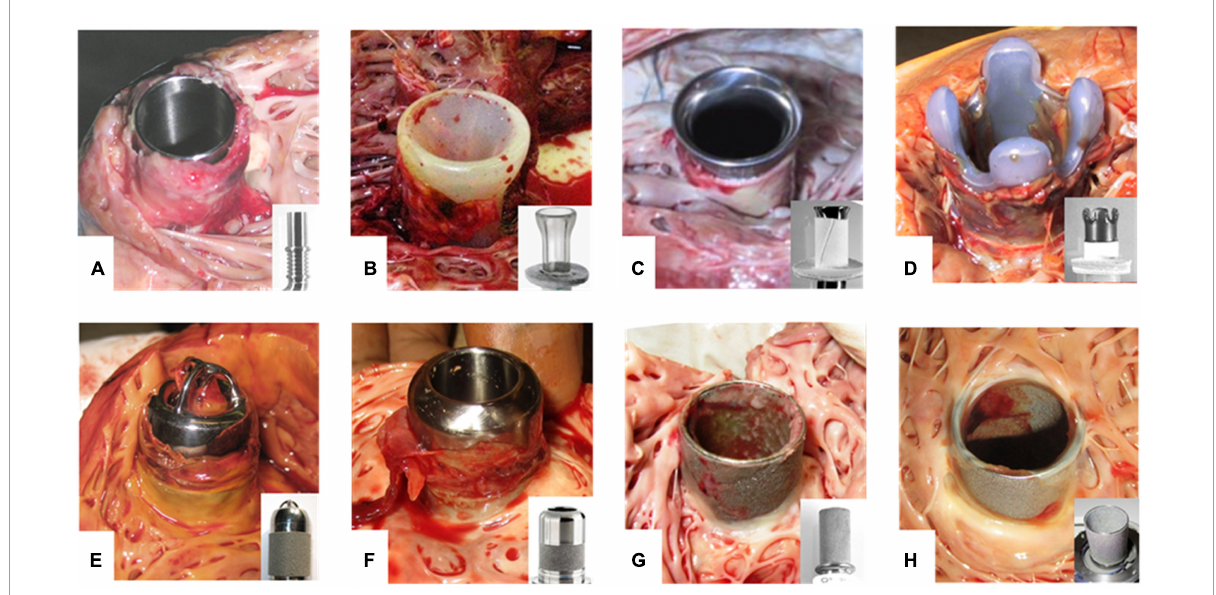
FIGURE1 Thrombus formation at LVAD inflow cannulas. (A–H) Inflow cannulas of various LVADs after explanation. Cannulas without any textured surface are prone to thrombus development of unhindered growth (A,B) . Textured cannulas show scar tissue at the well healed myocardial wound of the entry site covering the lower section with a textured surface consisting of woven polyester cuff (C,D) or sintered titanium microspheres (E–H) . Intracaval sintered parts of the cannula frequently are covered by fibrin layers of various thickness (G,H) . Especially at intraluminal parts these layers may form patchy structures or increased thickness with the risk of constricting the flow path or peeling off. Thrombus formation often is originating from the transition to the polished tip with uncontrolled growth. EC lining should prevent thrombus formation and propagation. (A) DuraHeart (Terumo Heart, Inc., Ann Arbor, MI, USA), totally polished titanium inflow cannula. (B) VentrAssist (Ventracor, Chatswood, NSW, Australia), smooth silicone cannula without texturing. (C) DeBakey pump (MicroMed Cardiovascular, Inc., Houston, TX, USA), lower part textured with Dacron cuff, polished titanium cannula. (D) INCOR (BerlinHeart, Berlin, Germany) with Dacron cuff and smooth silicone tip. (E) Jarvik-2000 (Jarvik Heart, New York, NY, USA). (F) HVAD (Medtronic Inc., USA) inflow cannula featuring about 50% sintered